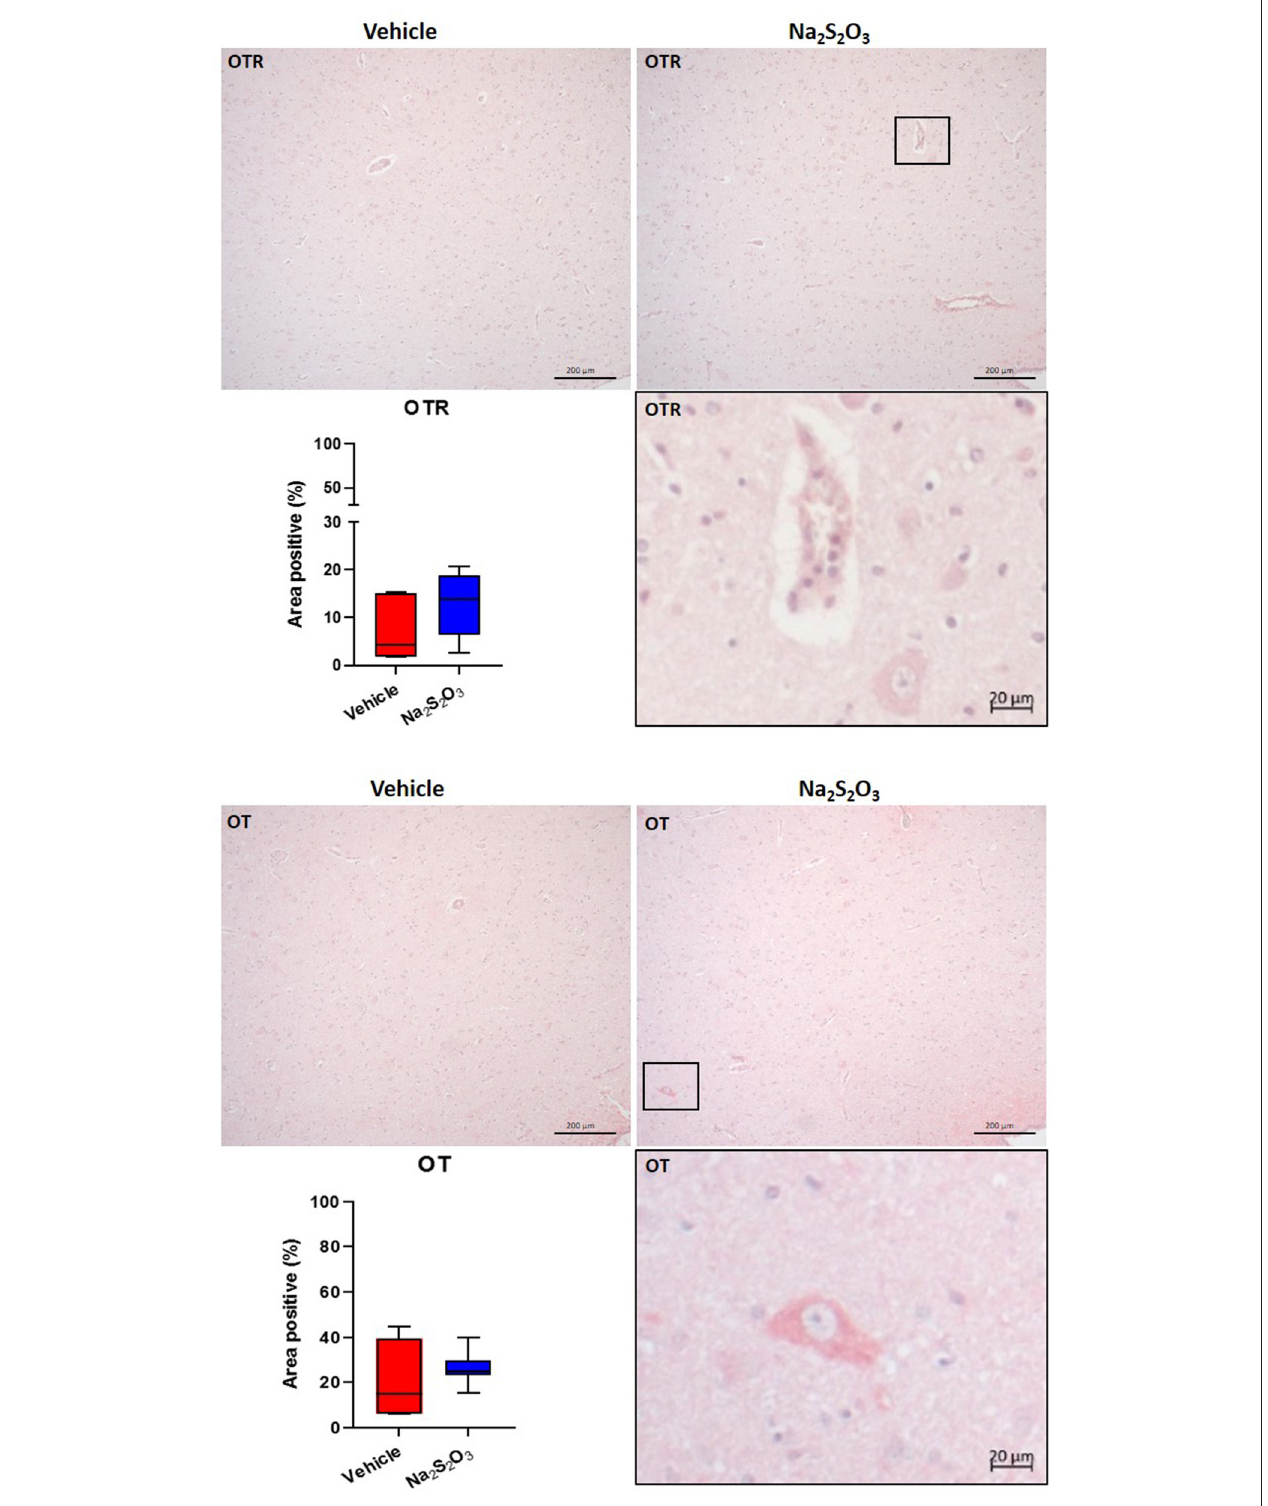
FIGURE 3 | OTR and OT in the porcine PVN. Quantification of the immunohistochemical stainings as positive percentage area in the PVN for the OTR (vehicle: n = 5; Na 2 S 2 O 3 : n = 7) and OT (vehicle: n = 5; Na 2 S 2 O 3 : n = 7). Boxes represent the interquartile ranges with the median (black line), whiskers represent minimum and maximum values. Exemplary immunohistochemical pictures of the OTR and OT in the PVN of vehicle and Na 2 S 2 O 3 treated animals (10X). Higher magnification pictures of the OTR and OT originate from the black box in the respective 10X picture. OT, oxytocin; OTR, oxytocin receptor; Na 2 S 2 O 3 , sodium thiosulfate.